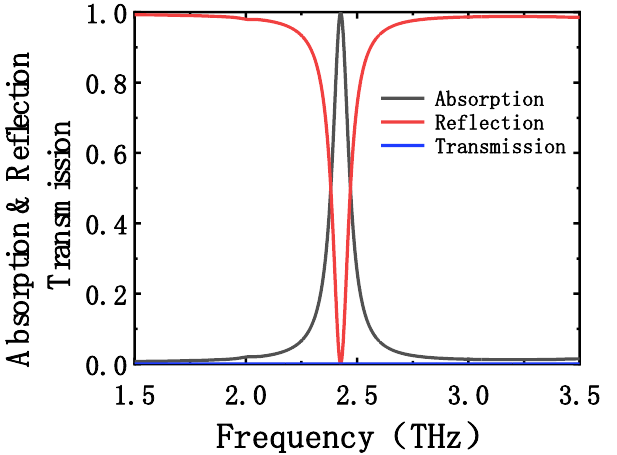
Figure 4. Simulated reflection, transmission, and absorption spectra of the proposed PMMA when the external temperature T is 280 K.